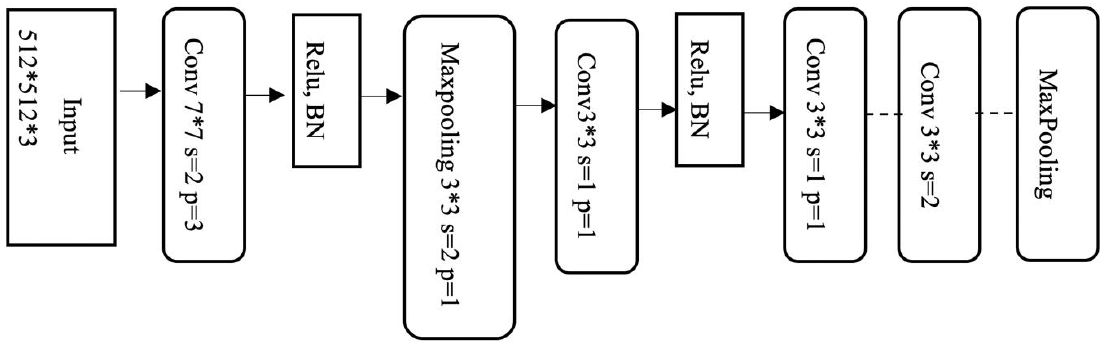
Figure 12. Block diagram of the ResNet-34 in the encoder of Res BCDU-Net.